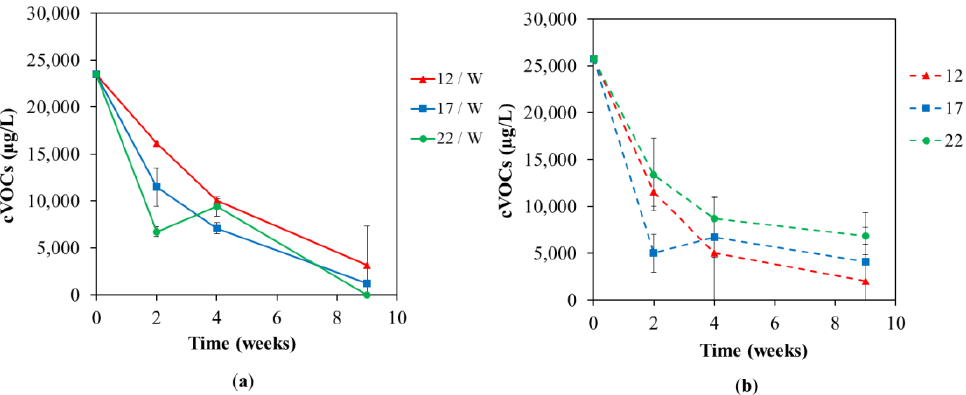
Figure 1. The concentration of chlorinated ethenes (cVOCs) in the groundwater at different tempera- tures of 12 ◦ C, 17 ◦ C, and 22 ◦ C during the lab-scale test with ( a , b ) without whey